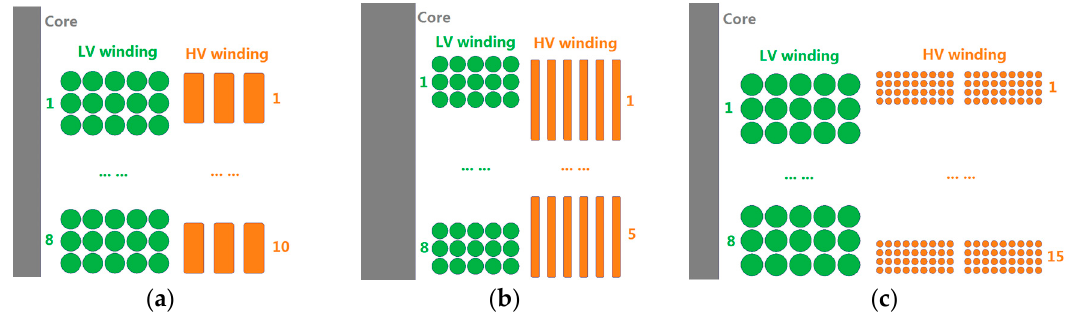
Figure 4. Winding arrangements for different windings: ( a ) N-4; ( b ) N-5; ( c ) N-6.